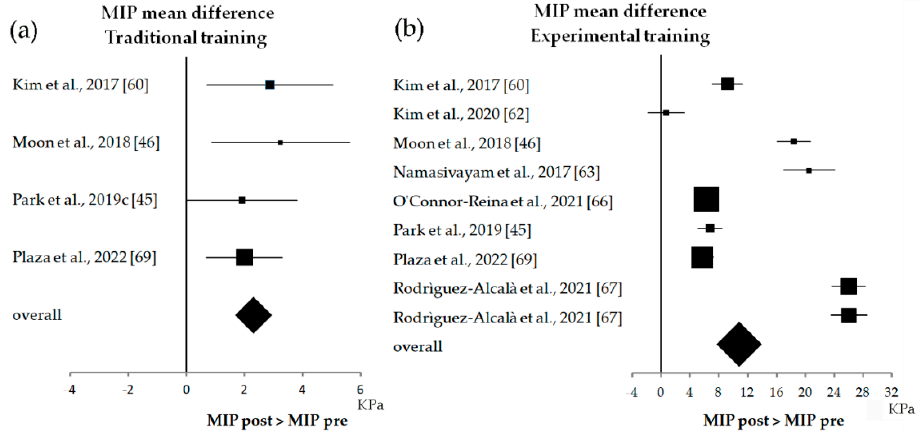
Figure 8. Forest plot of the MIP results for traditional training ( a ) and experimental training ( b ).